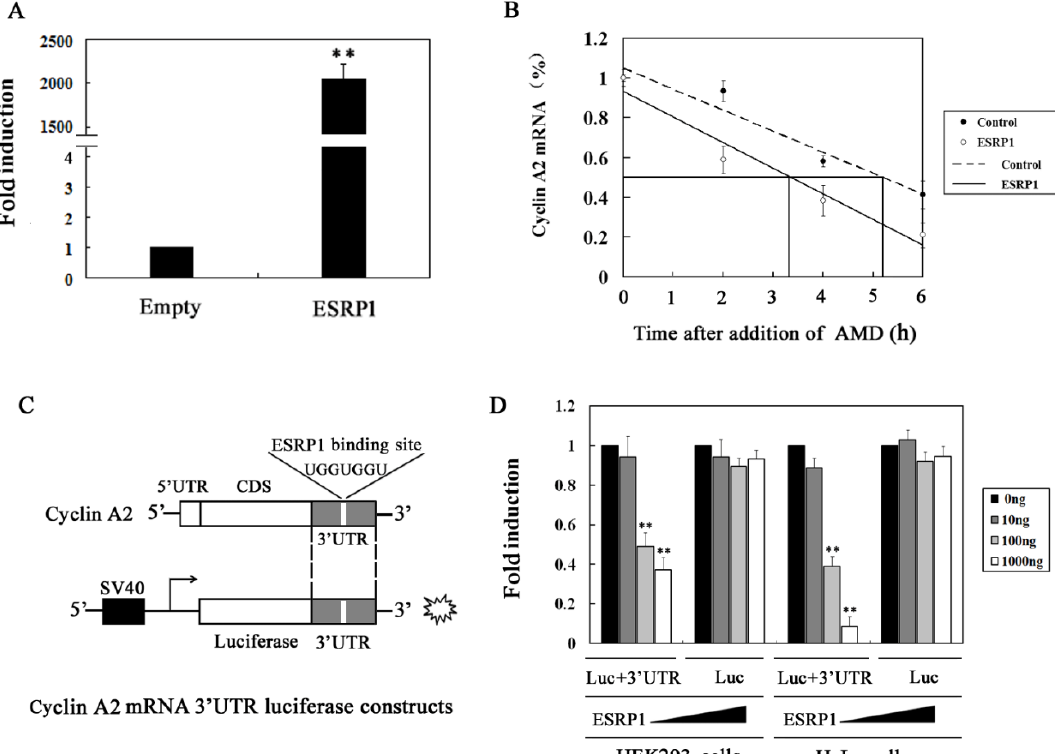
Figure 3. ESRP1 overexpression leads to decreased cyclin A2 mRNA stability. ( A ) 48 h after transfection with an ESRP1 vector, ESRP1 expression in HeLa cells was detected by qRT-PCR. ( B ) 24 h following ESRP1 vector transfection, cells were treated using 5 g/mL actinomycin D (AMD), with RNA being isolated at the indicated times, after which cyclin A2 expression was determined via qRT-PCR. ( C ) Schematic diagram of the construction of a luciferase-cyclin A2 3′ UTR chimeric vector generated via subcloning the cyclin A2 3′ UTR region into the pEZX-MT06 vector encoding firefly luciferase. ( D ) HeLa cells or HEK293 cells in 24-well plates were co-transfected with full-length vector or control vector, along with ESRP1 vector (0, 10, 100, and 1000 ng), and after 48 h, cells were lysed and luciferase activity was assessed. For normalization of luciferase activity, the signal (1 μg protein) for control cells was set to 1. This experiment was repeated three times ( n = 3); error bars indicate standard error; ** p < 0.01.